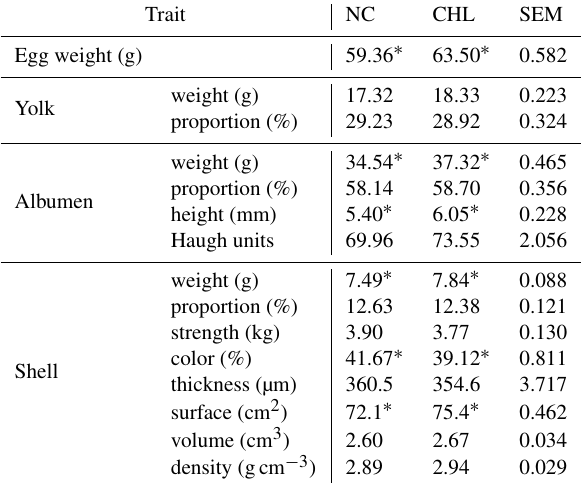
Table 2. The quality traits of whole egg and its each elements de- pending on